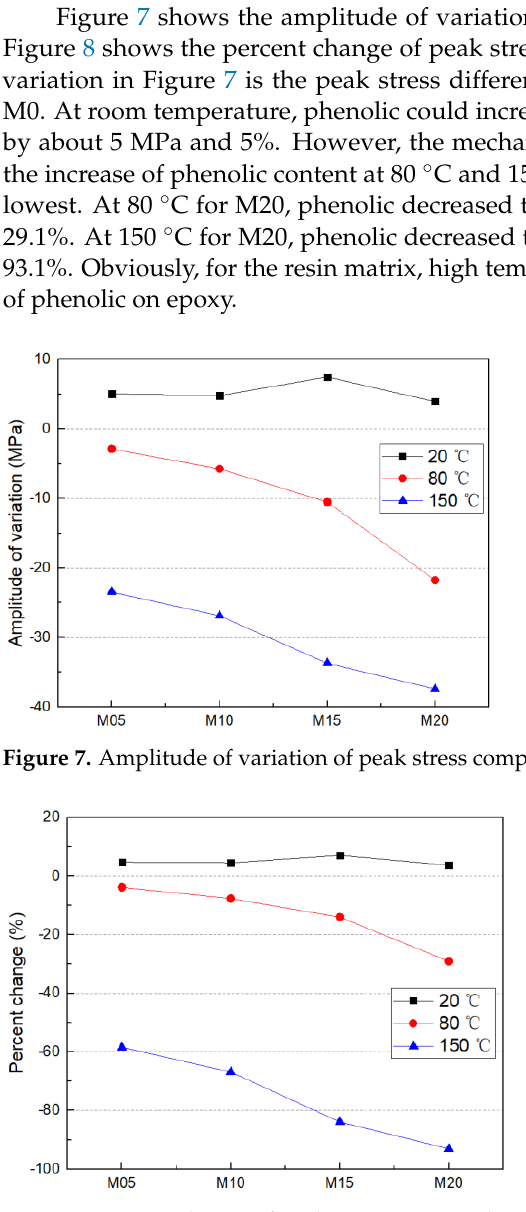
Figure 8. Percent change of peak stress compared with